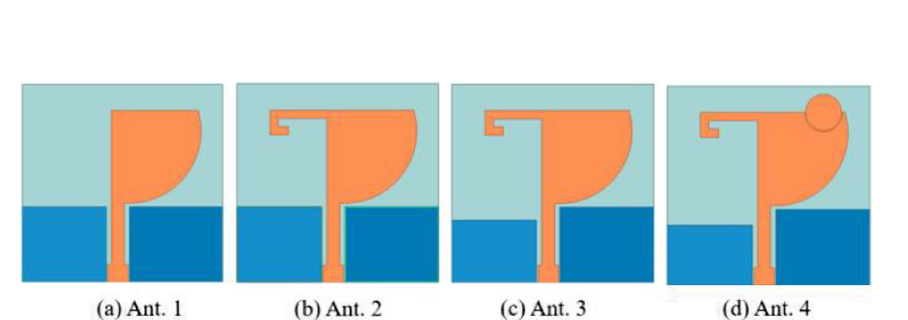
Fig. 2 The schematic structures of the four evolutions during the design process. a Ant. 1. b Ant. 2. c Ant. 3. d Ant. 4. Ant.4 is the accomplished antenna in the